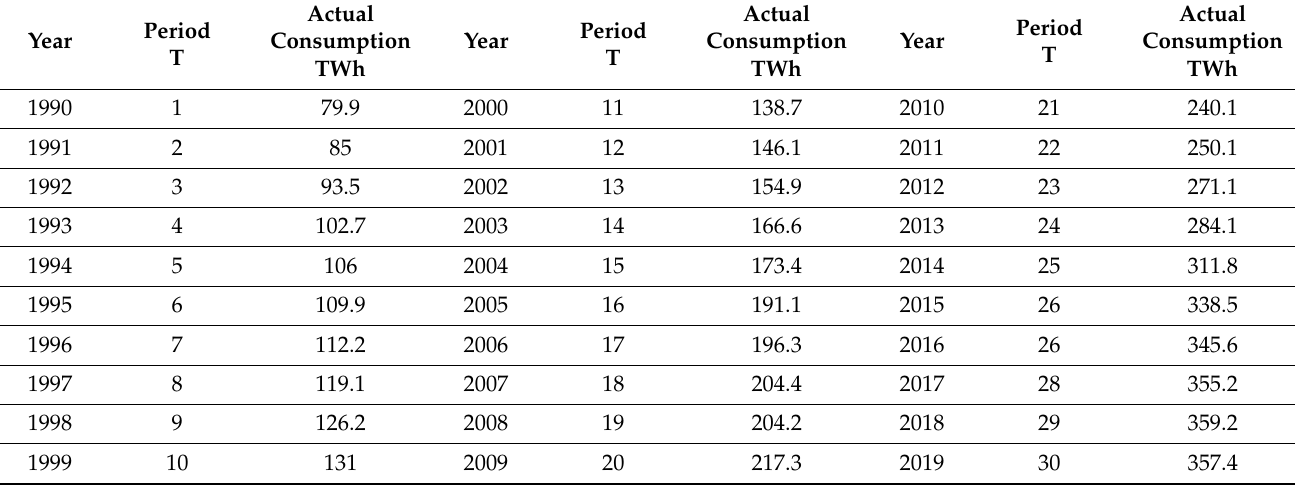
Table A1. Electricity Consumption Time Series (Research